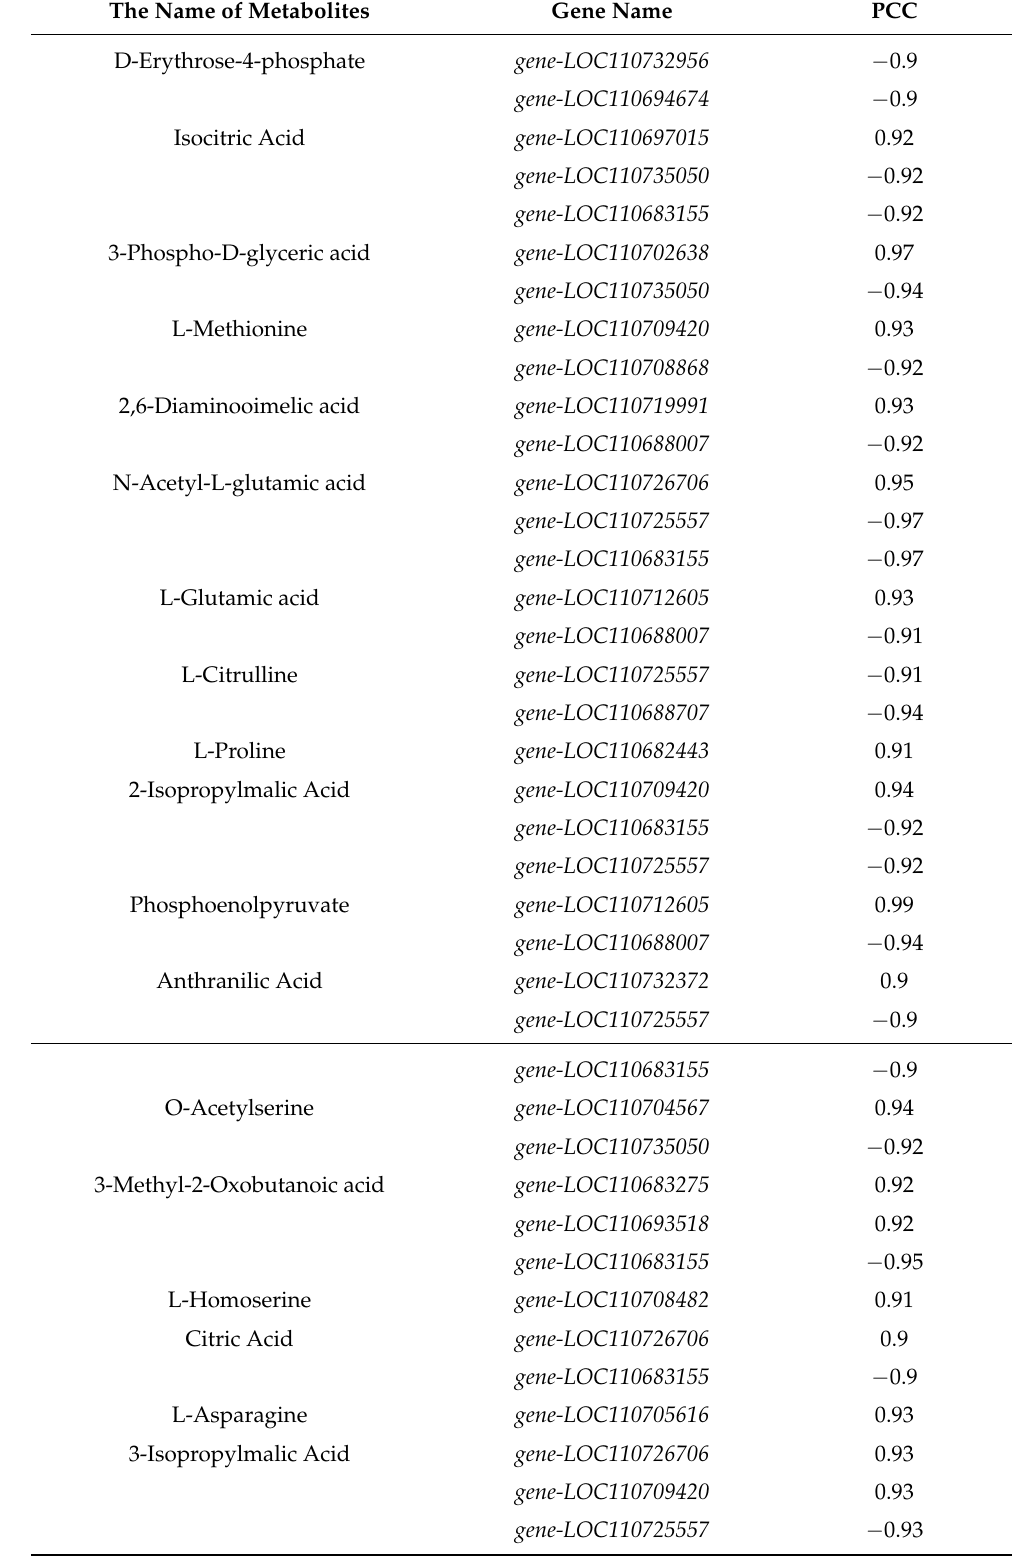
Table 5. Correlation between differential genes and differential metabolites in amino acid biosynthesis